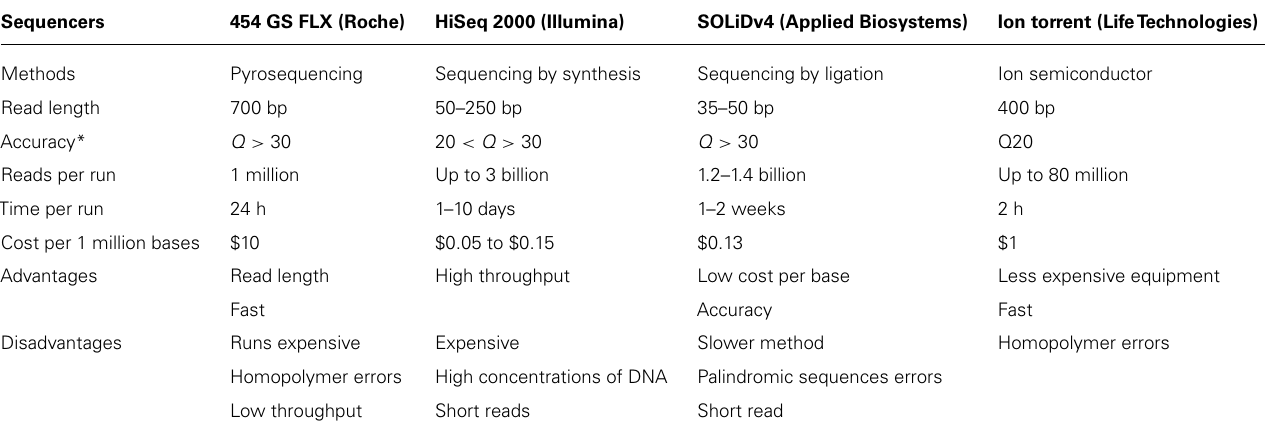
Table 1 |The main characteristics of the most common Next-Generation Sequencing (NGS) platforms (modified from Liu etal., 2012; Li etal., 2014).